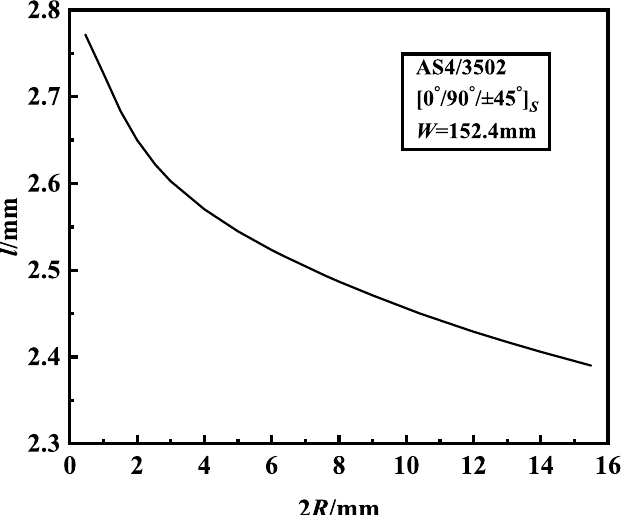
Figure 5. The crack extension at failure of [ 0 ◦ /90 ◦ / ± 45 ◦ ] hole diameters.